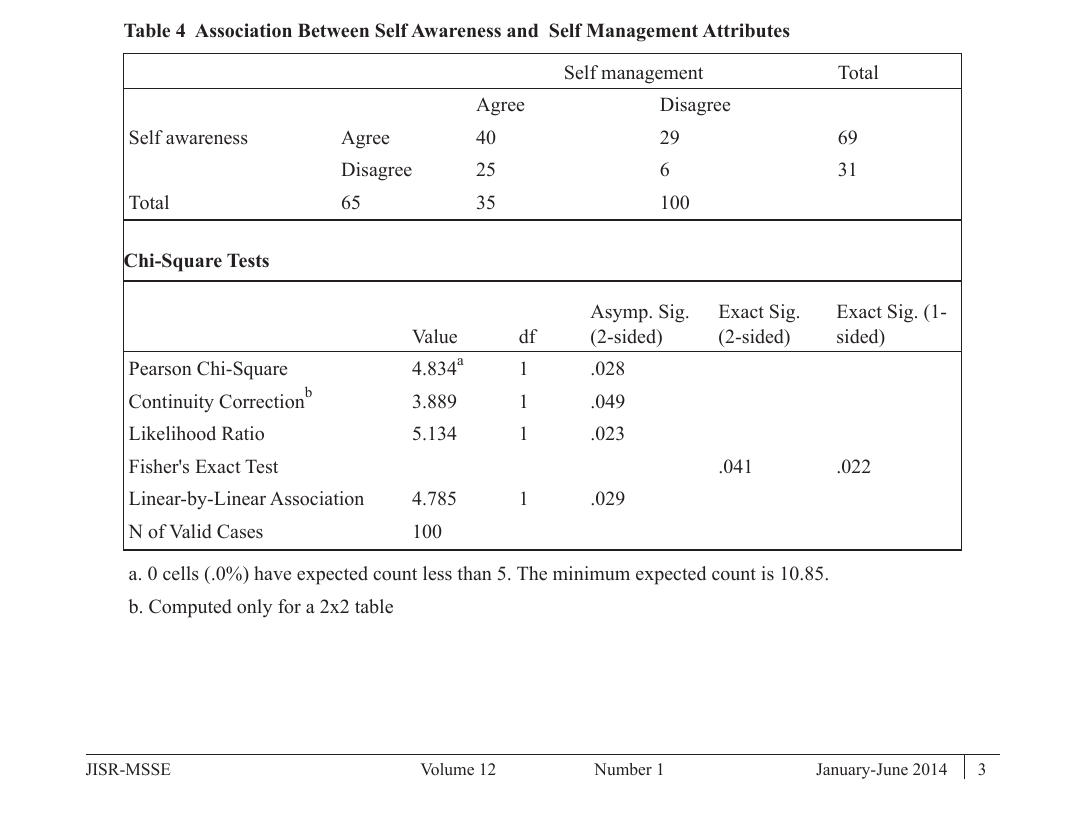
Table 4 Association Between Self Awareness and Self Management Attributes